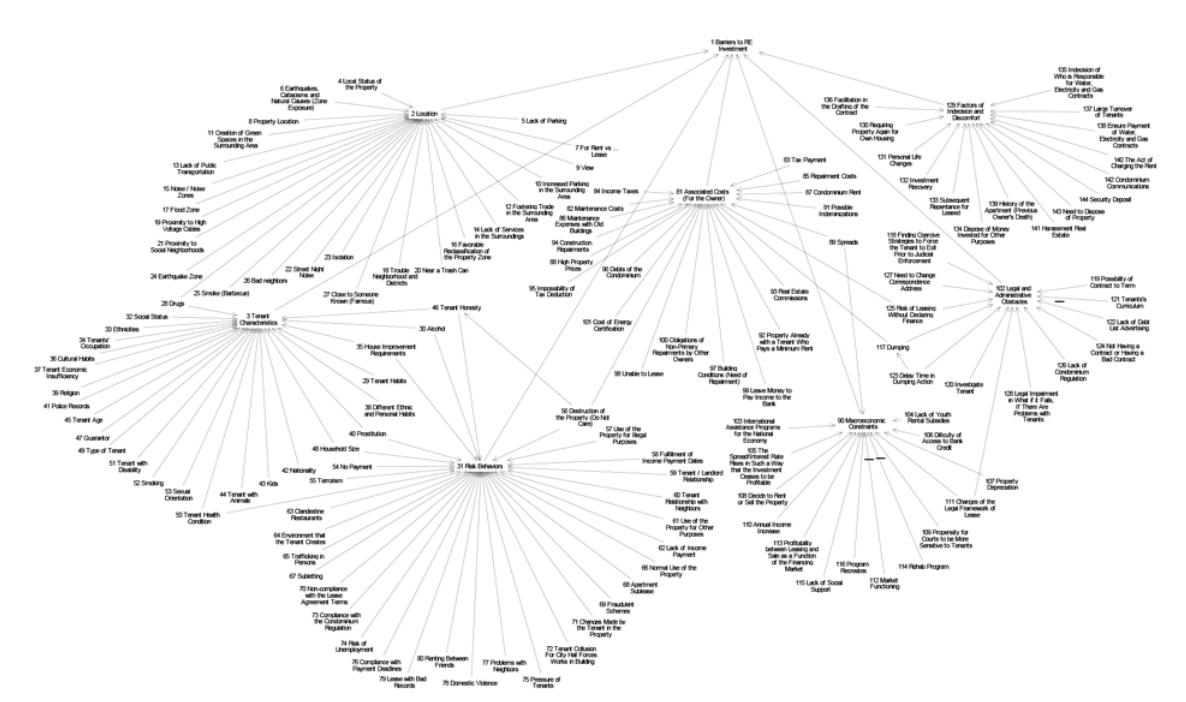
Figure 3. Group cognitive